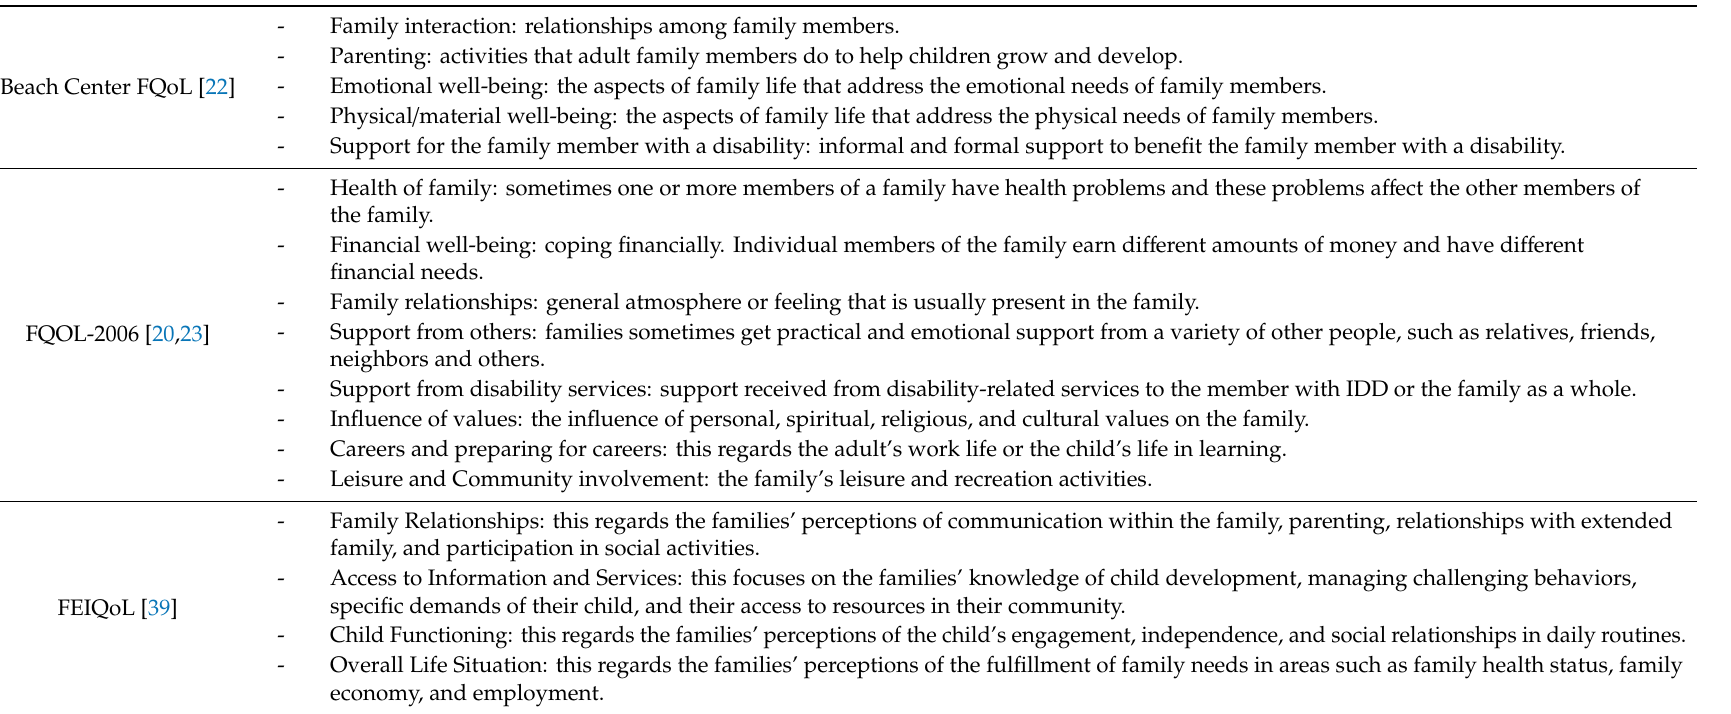
Table A1. Dimensions of the Beach Center FQoL [22], FQOL-2006 [20,23], and FEIQoL [39] and their definitions.